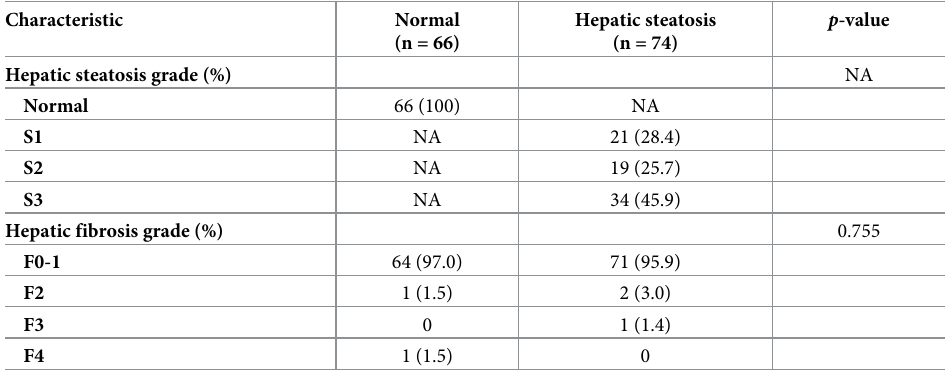
Table 2. Hepatic steatosis and fibrosis of the study